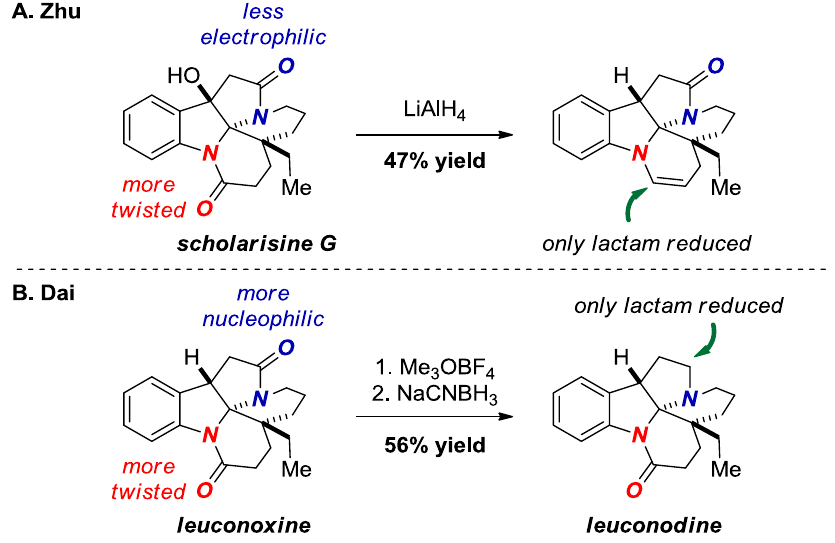
Figure 19. Reduction of a Bridged Lactam in Scholarisine G ( A ) and Leuconoxine Alkaloids ( B ).